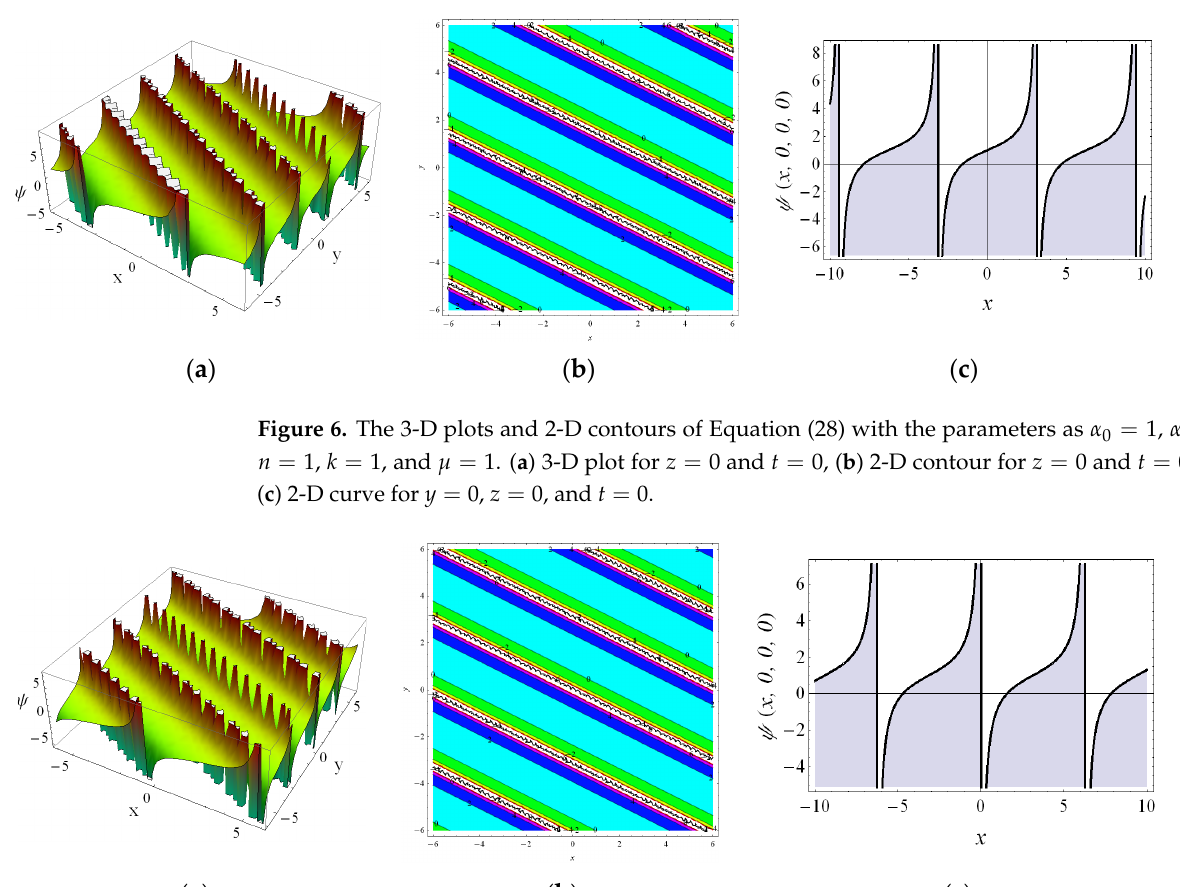
Figure 7. The 3-D plots and 2-D contours of Equation (29) with the parameters as α 0 = 1, m = 1, n = 1, s = 1, and µ = 1. ( a ) 3-D plot for z = 0 and t = 0, ( b ) 2-D contour for z = 0 and t = 0, ( c ) 2-D curve for y = 0, z = 0, and t =